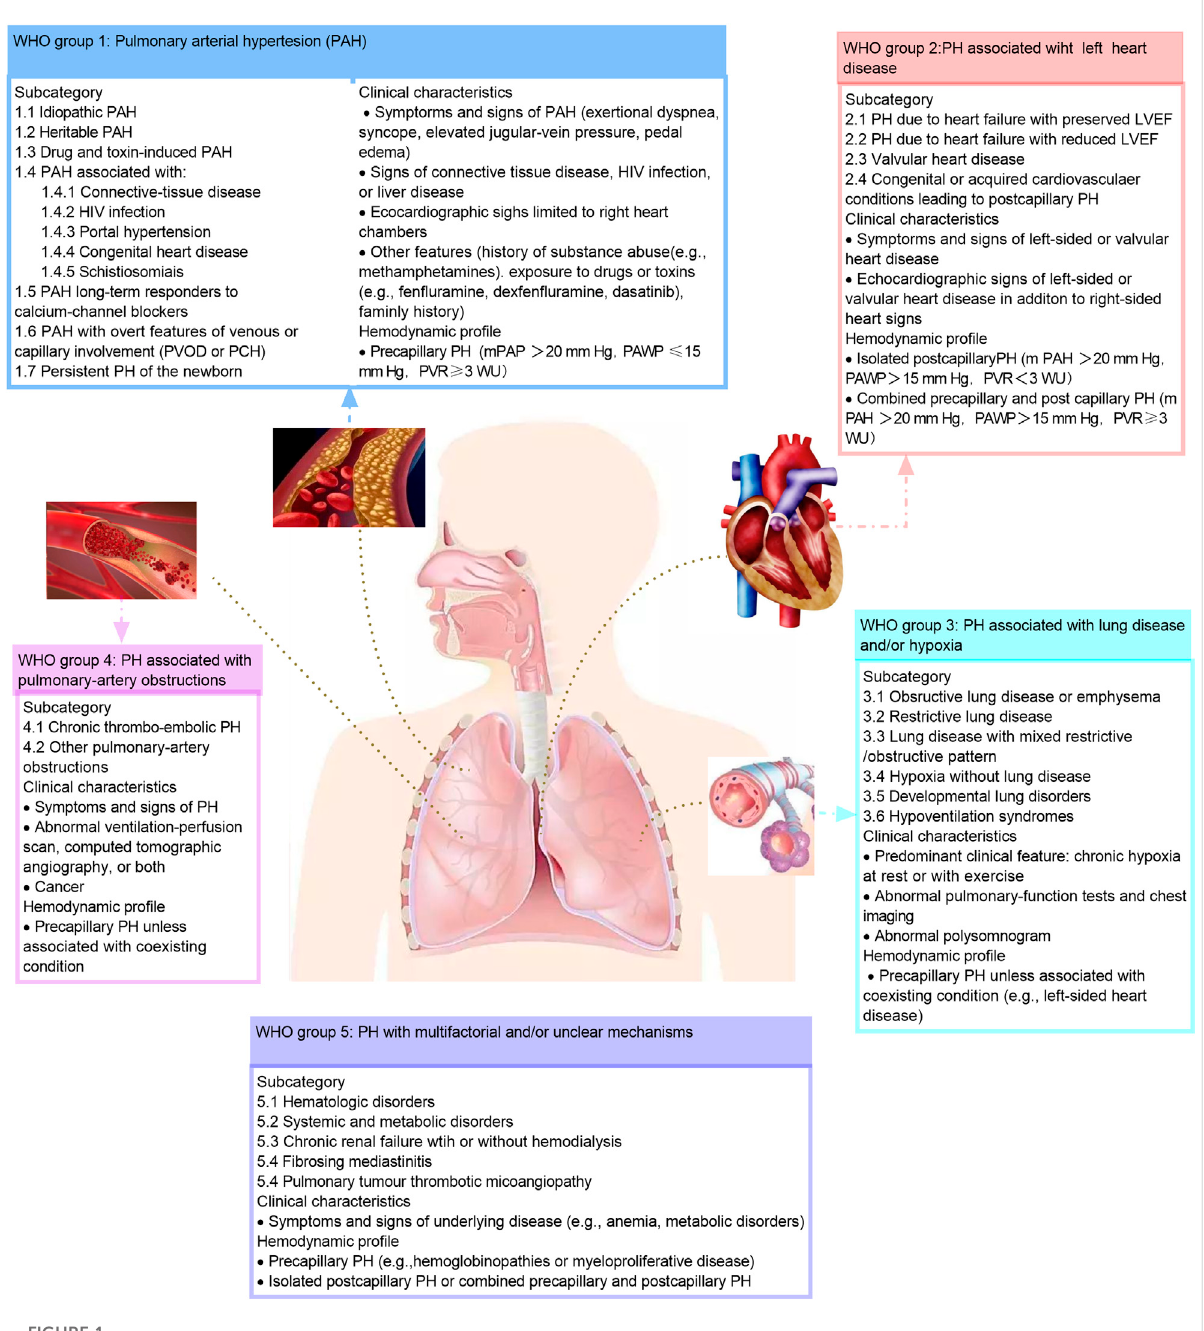
FIGURE 1 Clinical classi fi cation of pulmonary hypertension. The classi fi cation of the pulmonary hypertension based on the 2018 World Hypertension Symposium meeting. HIV, human immunode fi ciency virus; LVEF, left ventricular ejection fraction; mPAP, mean pulmonary artery pressure; PAH, pulmonary artery hypertension; PAP, pulmonary artery pressure; PAWP, pulmonary artery wedge pressure; PCH, pulmonary capillary hem- angiomates; PH, pulmonary hypertension; PVOD, pulmonary arterial veno-occlusive disease; PVR, pulmonary vascular resistance; RV, right ventricular; WU, wood unites. This fi gure is modi fi ed from Figure 1 in Hassoun,